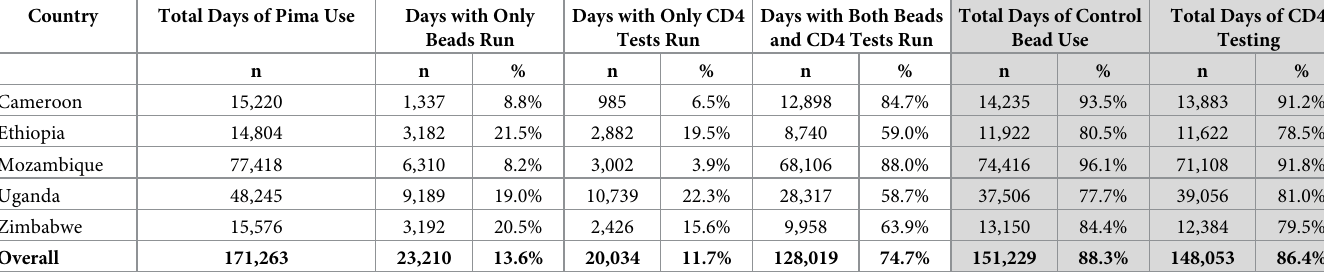
Table 5. Control bead and CD4 testing run days by country and all countries